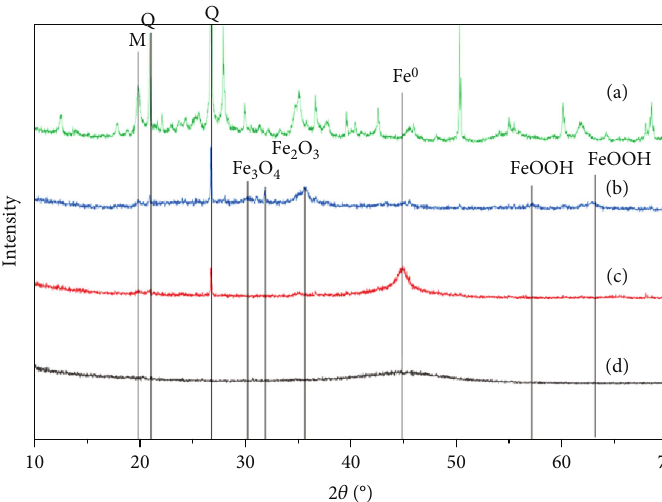
Figure 2: XRD images of (a) ATP, (b) nitrate-laden ATP-nZVI, (c) ATP-nZVI, and (d) nZVI. ATP: attapulgite; ATP-nZVI: nano-zero- valent iron-coated attapulgite; nZVI: nano-zero-valent iron.